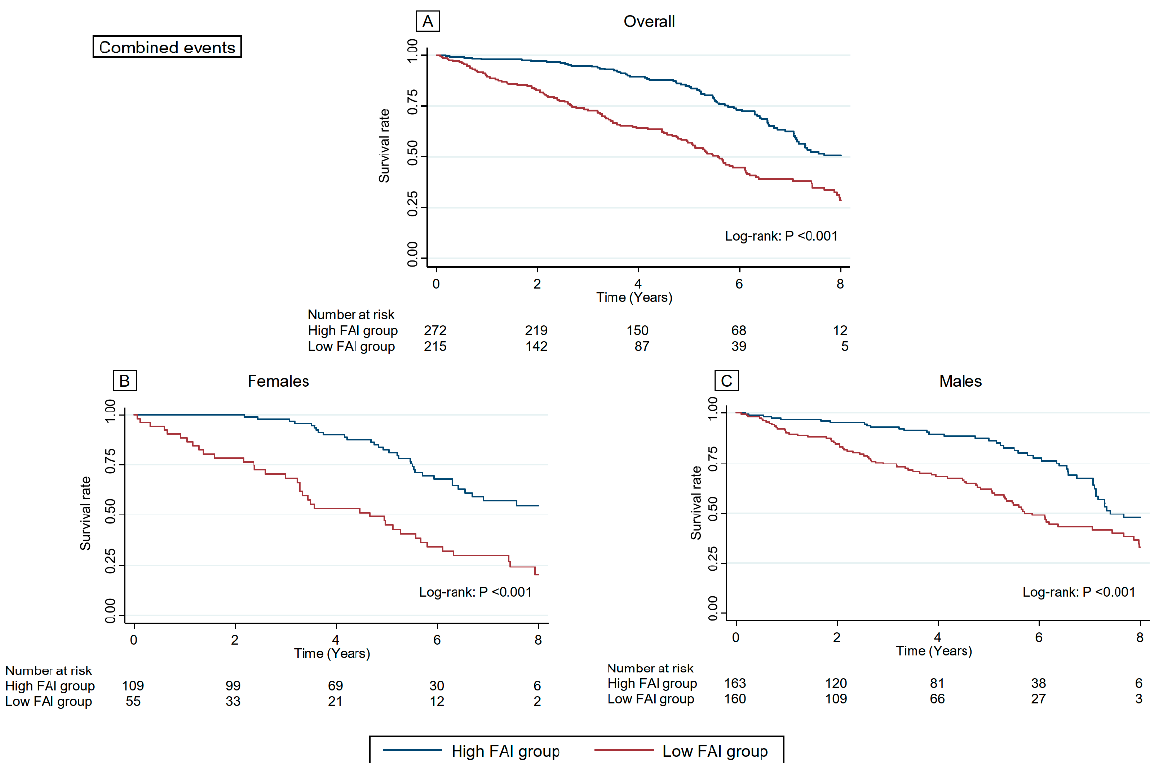
Figure 3. Kaplan–Meier curve for all-cause mortality according to the FAI in the overall cohort, fe- males, and males. The all-cause mortality was significantly higher in the low FAI score group than those in the high FAI score group in the overall cohort ( A ), females ( B ), and males ( C ). FAI, Frenchay Activities Index.